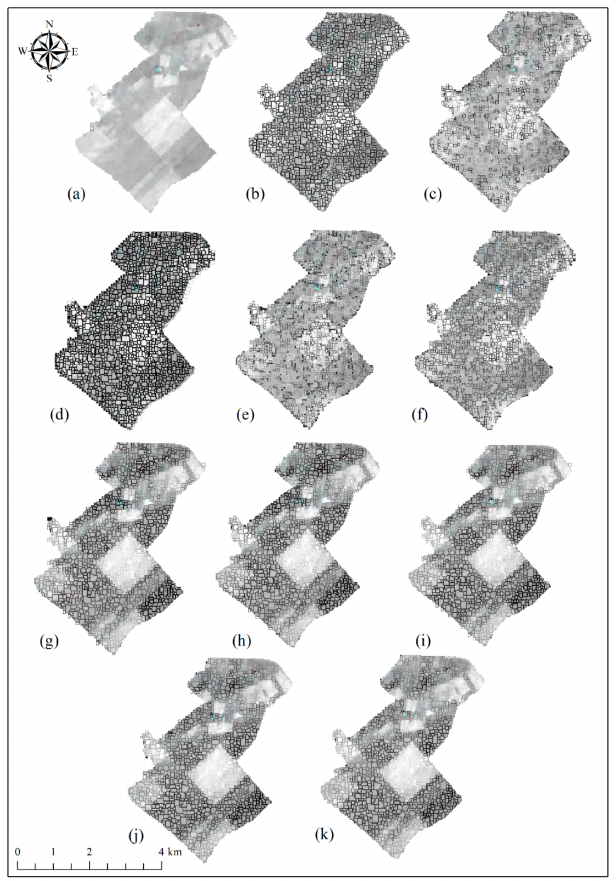
Figure 8. Applying brightness, GLCM after Haralick and tillage indices feature functions on the Sentinel-2 image: ( a ) brightness, ( b ) GLCM contrast, ( c ) GLCM correlation, ( d ) GLCM